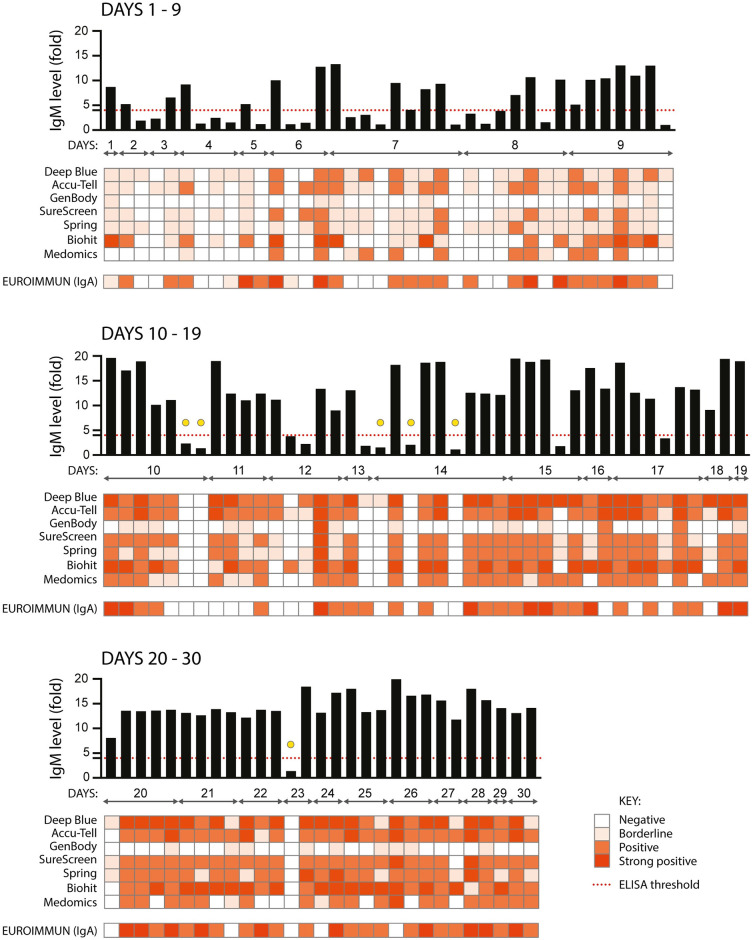
Comparison of nine serological assays for the detection of anti-SARS CoV-2 IgM and IgA.110 serum samples from 87 individuals with confirmed SARS-CoV-2 infection (RNA+ by RT-PCR) were assayed for anti-SARS CoV-2 IgM using an in-house anti-S ELISA (shown in the graph across the top of each panel, black bars), seven colloidal gold lateral flow tests (Deep Blue, Accu-Tell, GenBody, SureScreen, Spring, Biohit and Medomics), and for anti-S1 IgA using a commercial ELISA (EUROIMMUN). The threshold for a positive result in the in-house ELISA is set at 4-fold above background, as indicated by the red dashed line. Results for the other tests are represented as heatmaps, with colour intensity corresponding to strength of signal for each test. For EUROIMMUN, scores of <0.8 are negative, ≥0.8 to <1.1 are borderline, ≥1.2 to <4 are positive, and ≥4 are strong positive. Samples are grouped according to days post onset of COVID-19 symptoms, and squares aligned in columns under each bar of the graph show results for a single serum sample. Yellow circles indicate samples from 10 days or more POS that were negative by ELISA and in at least 6 other tests, as detailed in the text.